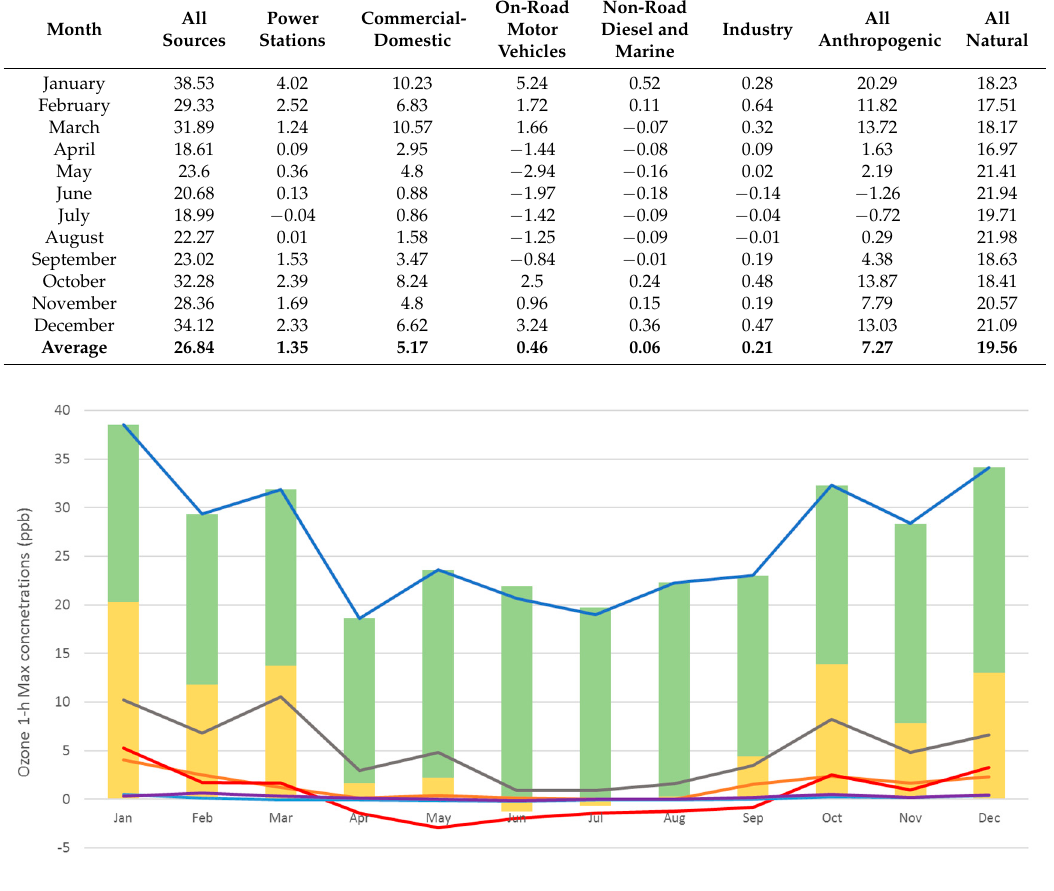
Table A1. Monthly average of daily maximum 1-h predicted ozone concentration (ppb) in the Sydney west region for different months in 2008 under various emission scenarios.